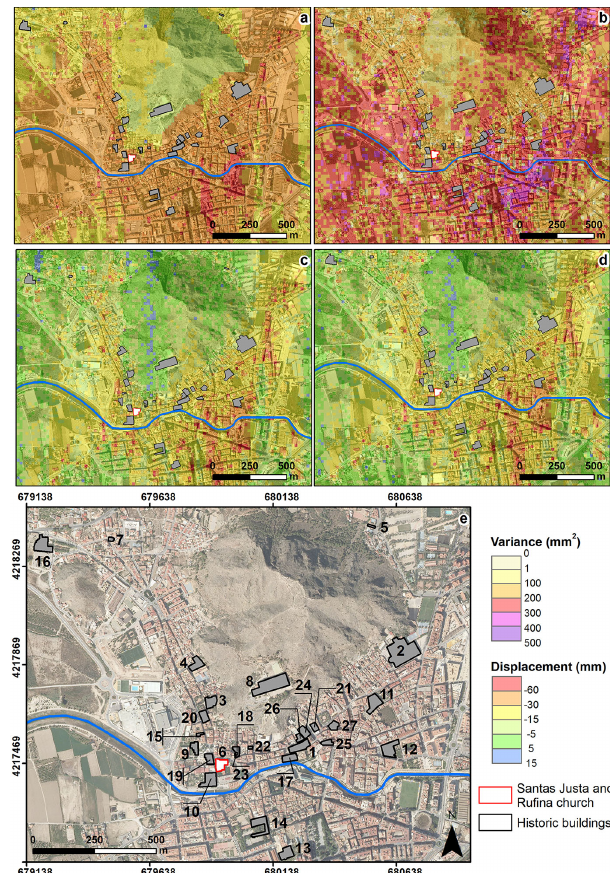
Figure 7. Sequential Gaussian conditional simulation results for the 1995–2005 period: (a) mean; (b) variance; (c) 68th percentile; (d) 95th percentile; and (e) location of historic buildings listed in Ta- ble